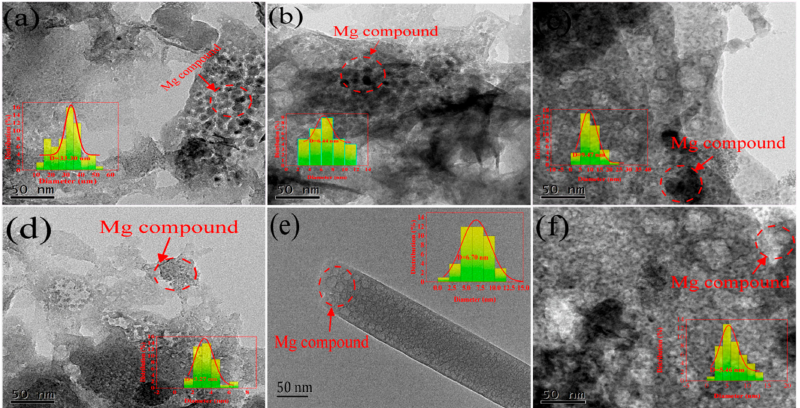
Figure 1. HRTEM images of six di ff erent Mg-loaded biochars. ( a ; b ; c ; d ; e ; and f represent BSB, FSB, MSB, CFSB, TSB, and CSB,